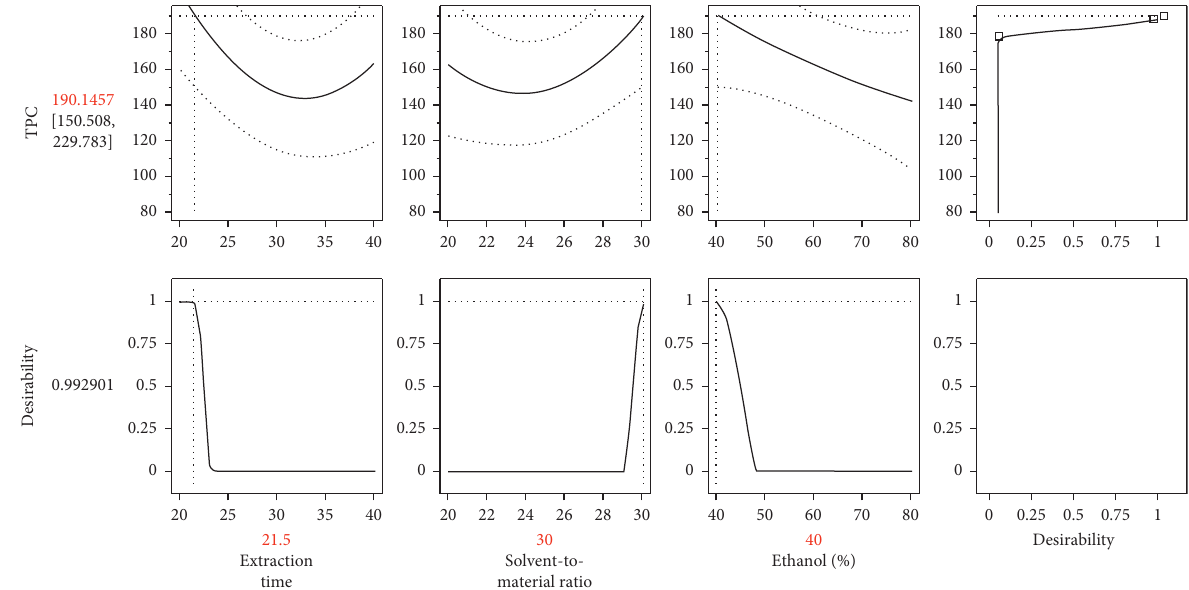
Figure 4: Desirability plot showing the precise operating conditions leading to the optimal TPC.